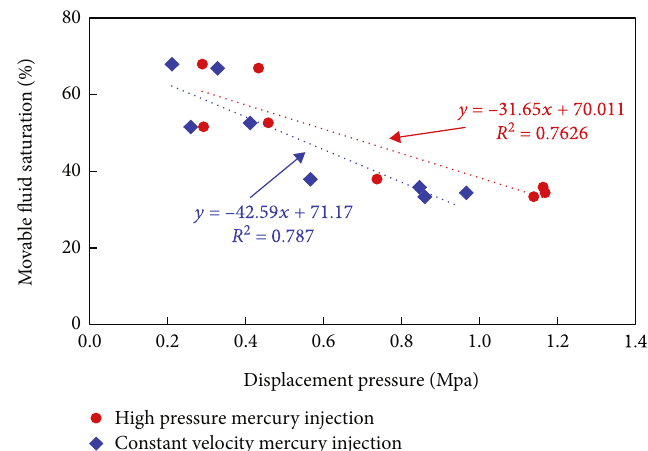
Figure 15: Relationship between displacement pressure and movable fl uid saturation.